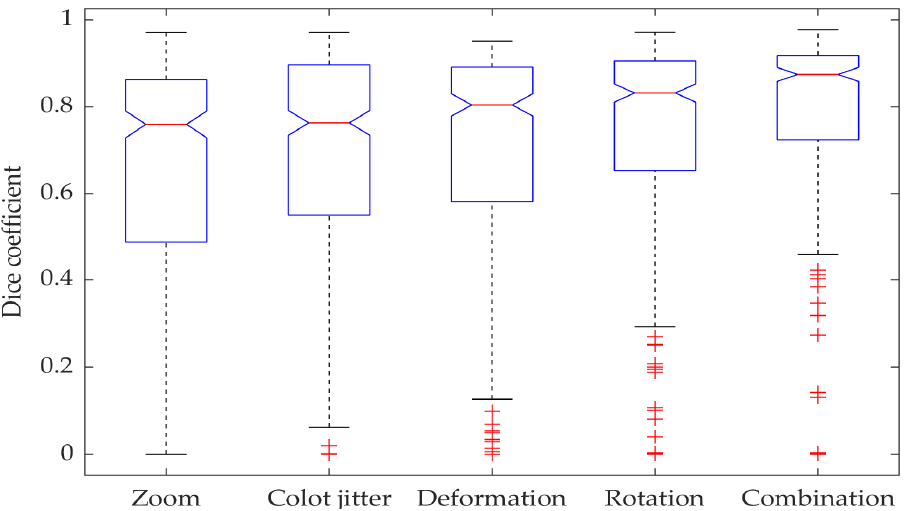
Figure 6. Box plot showing Dice coefficient results for data augmentation ablation tests with dilated ResFCN network.